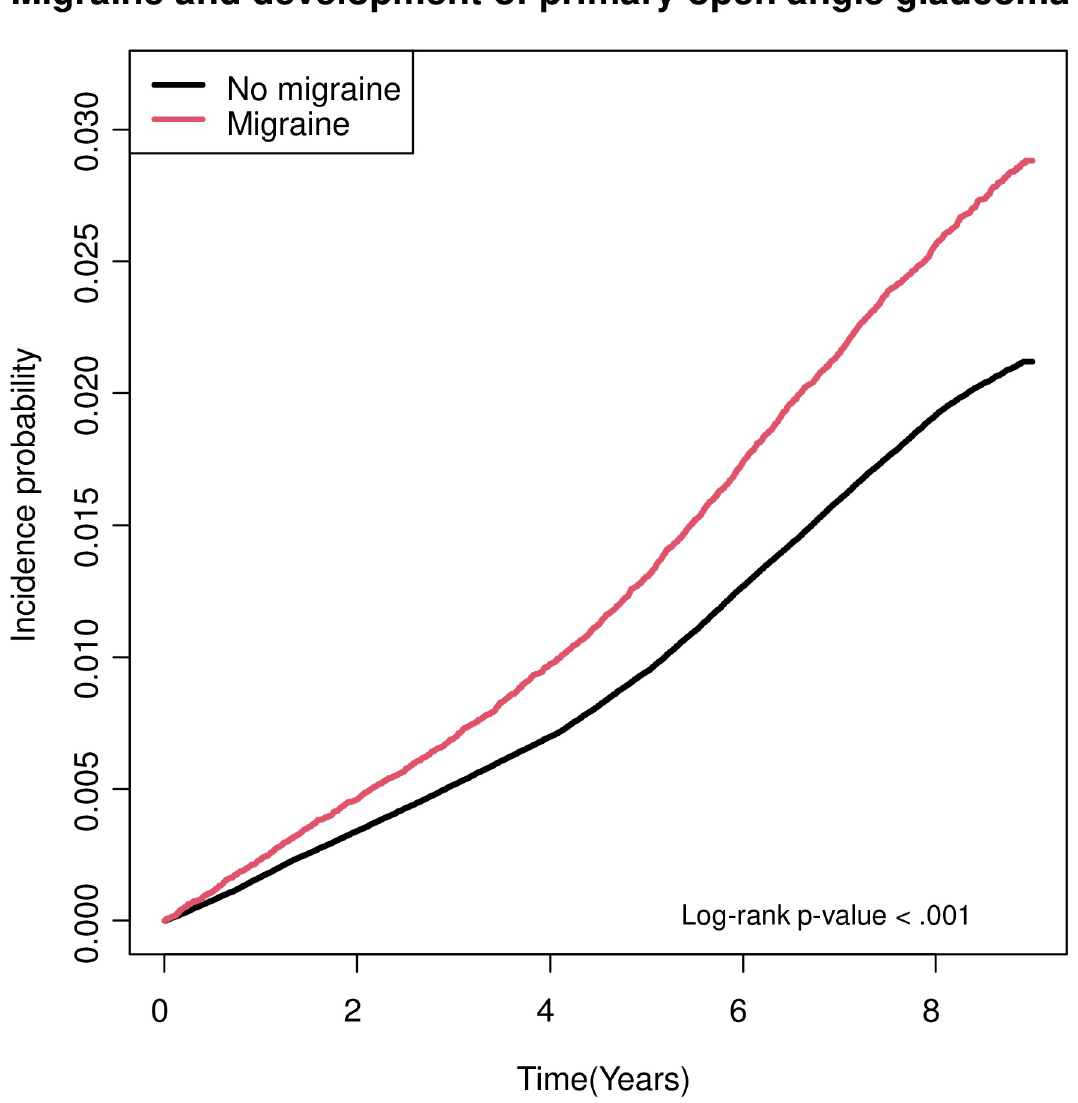
Fig 2. Cumulative incidence of POAG according to migraine